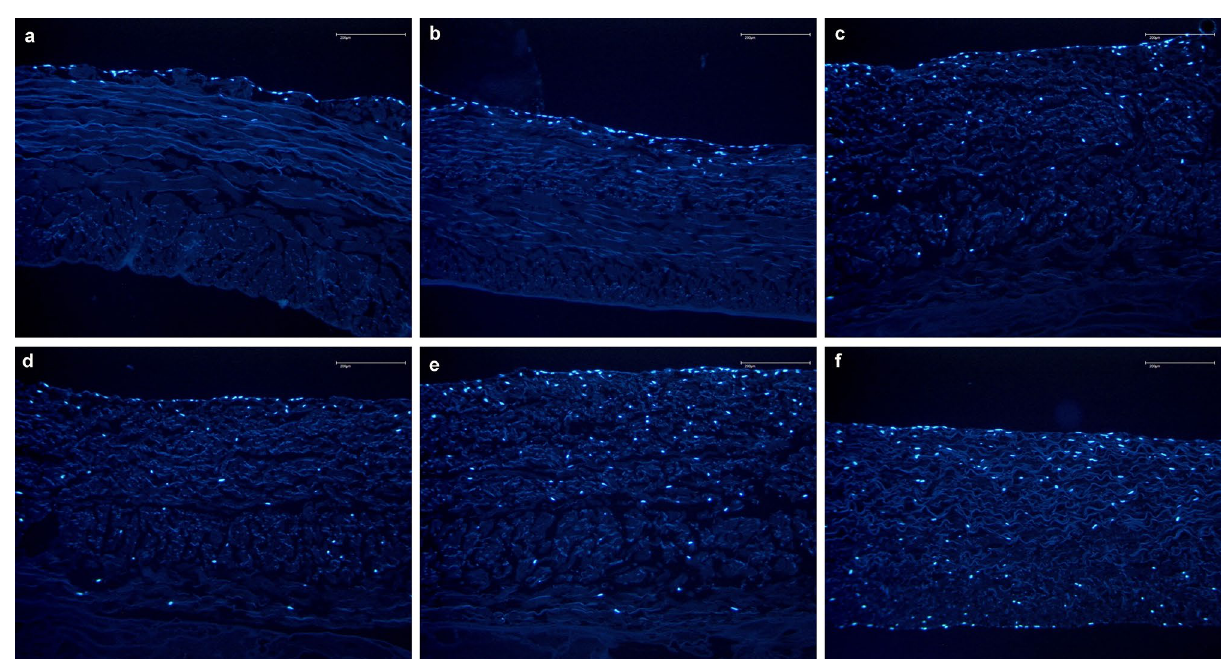
Figure 6. Proliferation and migration in the fibrin glued membrane using the DAPI stained cell nuclei of B-MSCs (blue) assay. Time dependent proliferation and migration of B-MSCs into the non-fibrin treated membrane over the 1, 2, 3, 4, 6, and 8 weeks (pictures a – f ,